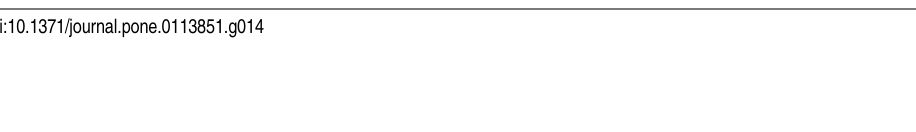
Figure 14. Plot of heat transfer coefficient Z for Hartman number m 1 with E ~ 0 : 1 , t ~ 0 : 01 , ª 1 ~ 4 , ª 2 ~ 6 ,